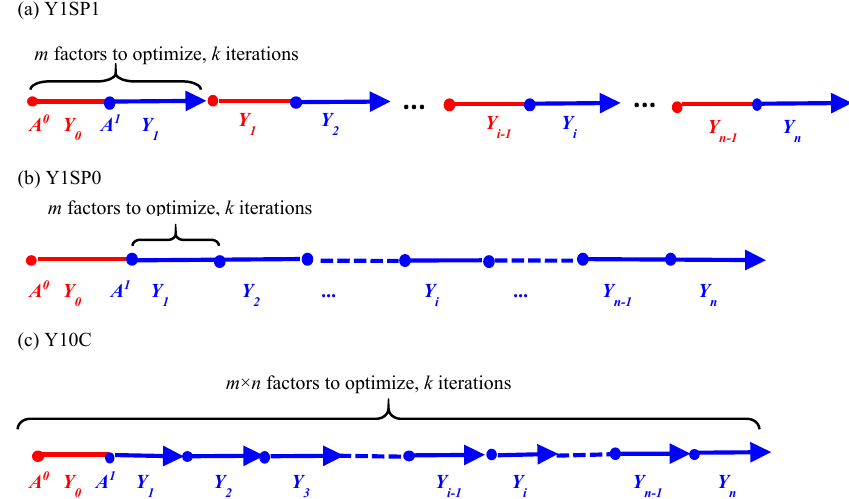
Figure 4. The setup of assimilation experiments for n years ( n = 10, 1980–1989) and k iterations ( k = 10) with m(m = 27) correction factors ( x) each year ( x is different over years). (a) The i th year ( Y i ) optimization is initialized by the end of Y i − optimization; (b) the 1 initial condition of Y i optimization is obtained by running Y i optimization fed with the same x as Y i ; (c) optimizing n years together with − 1 1-year spin-up at the beginning of n years. The Y1SP0 and Y1SP1 perform the optimization year by year. The blue and red colors mean optimization and spin-up simulations,